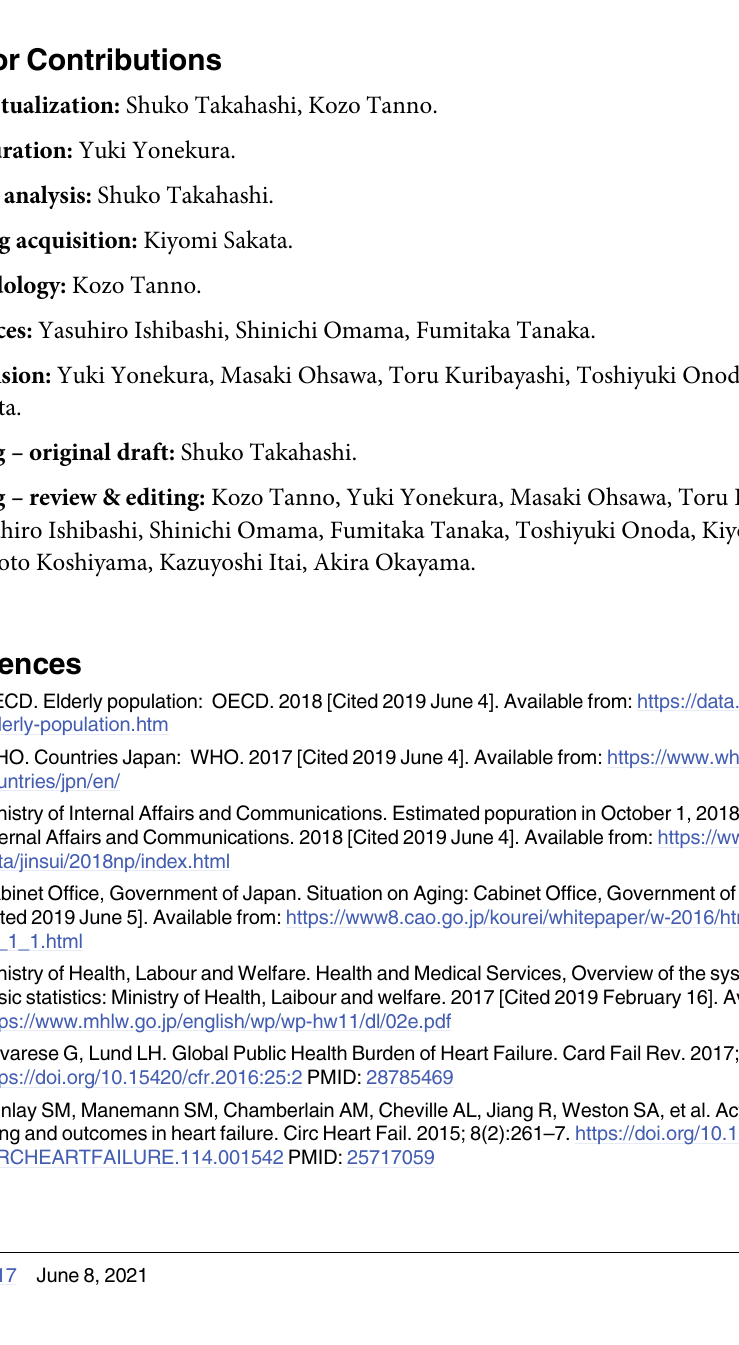
S3 Table. Explanation of